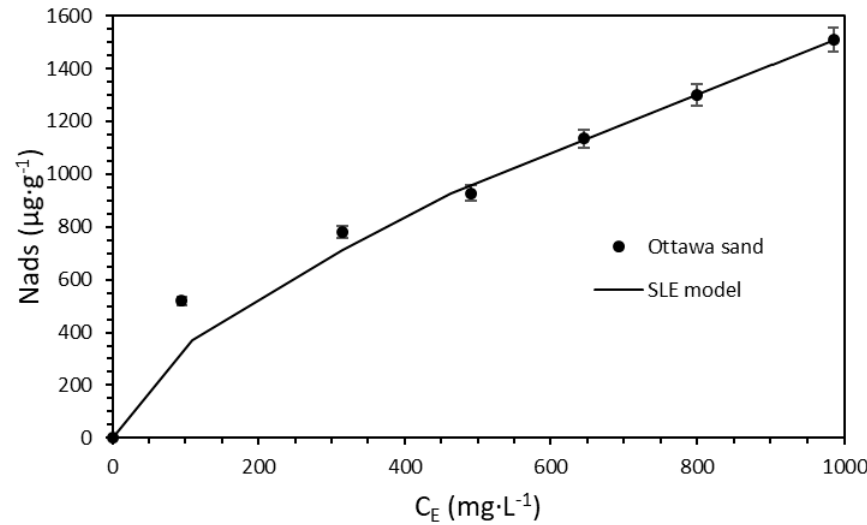
Figure 10. Adsorption isotherms constructed at a constant brine TDS of 0.75% with solutions prepared at 50 °C. The tests were performed using the thermogravimetric method with the SA system in the absence of nanoparticles and varying the surfactant concentration (100, 500, and 1000 mg·L − 1 ). The symbols represent the experimental data, while error bars represent standard deviation.